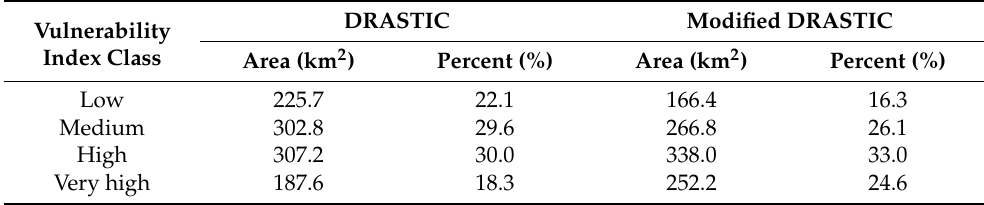
Table 7. Areal coverage of DRASTIC and modified DRASTIC vulnerability index